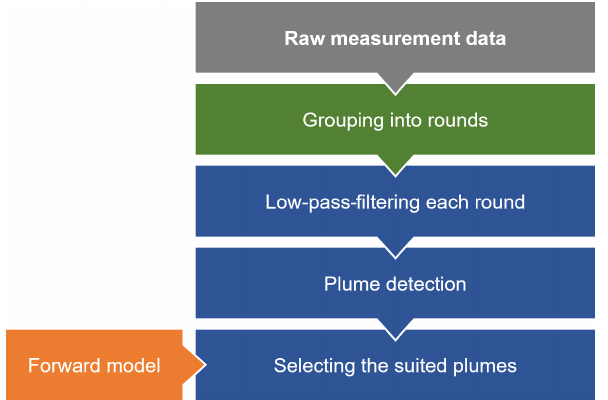
Figure 4. Flowchart visualizing the main steps performed on the raw measurement data in order to obtain an emission estimate.